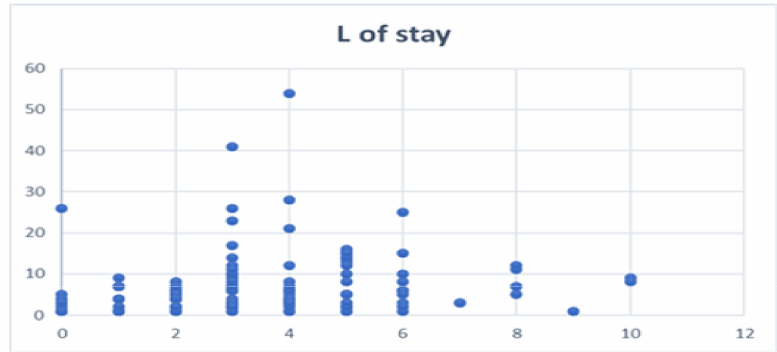
Figure 3. Length of stay by number of rib